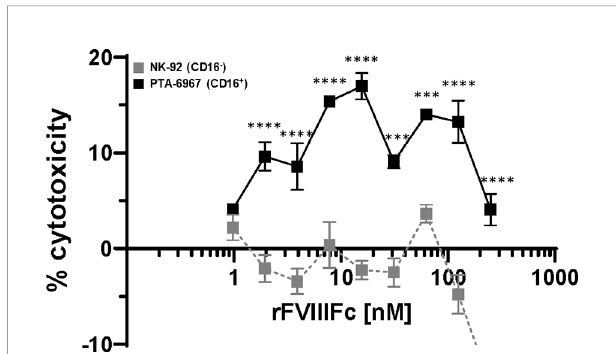
FIGURE 4 | rFVIIIFc induces BO2C11 (FVIII-speci fi c B-cell) lysis through interactions with CD16 + NK cells. Lactate dehydrogenase (LDH) release from target BO2C11 B-cells following 4 hour incubation at 37°C following incubation with rFVIIIFc (250 nM – 977 pM) and CD16 + NK cells [PTA-6967, black squares] or CD16 - NK cells [NK-92, grey squares] using a 5:1 effector to target ratio (100,000:20,000 cells per well); plotted as mean % cytotoxicity ± SEM (n = 4) from a representative of two experiments. % cytotoxicity was calculated as: % cytotoxicity = [(experimental well – spontaneous lysis control)/ (Triton X-100 maximal lysis control – spontaneous lysis control)] * 100. Tukey ’ s multiple comparisons tests (two-tailed) were performed at each rFVIIIFc concentration comparing responses between CD16 - (NK-92) and CD16 + (PTA- 6967) NK cells. ***p < 0.001, ****p <